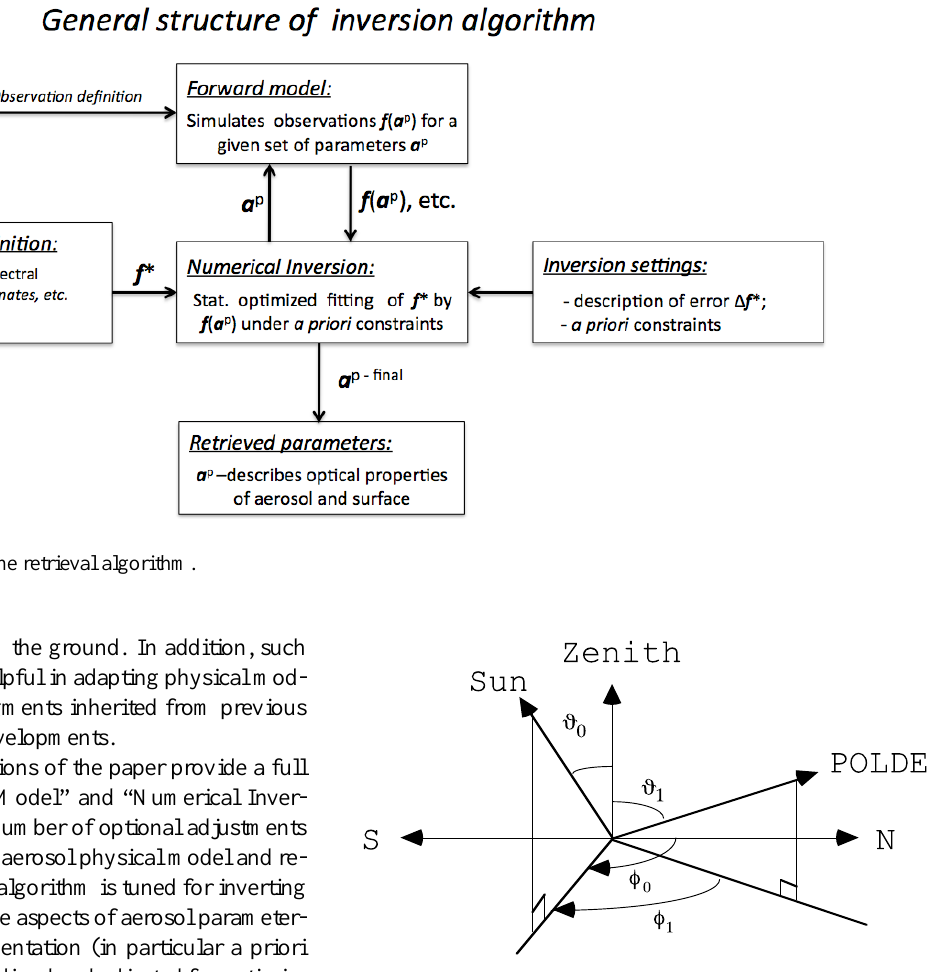
3 Fig. 2. The illustration of the angular convention used for POLDER observation